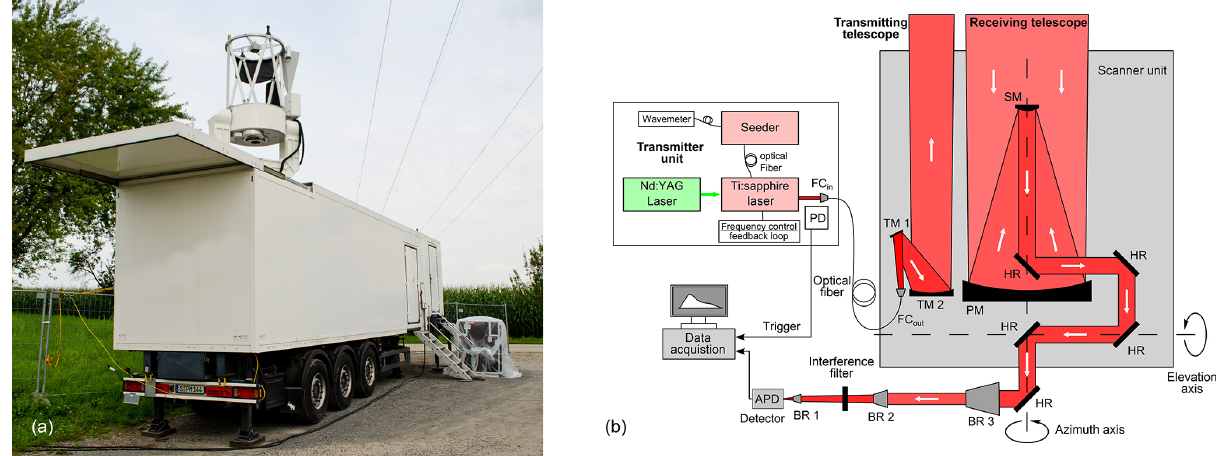
Figure 1. (a) Photograph of the DIAL system in the field during the SABLE experiment. (b) Setup of the UHOH DIAL system with transmitter unit, the scanner unit with transmitting and receiving telescope, and the detection path with data acquisition. TM – transmitting telescope mirror, PM – primary mirror, SM – secondary mirror, HR – high-reflection mirror, BR – beam reducer, APD – avalanche photo diode, PD – photo diode, FC – fiber